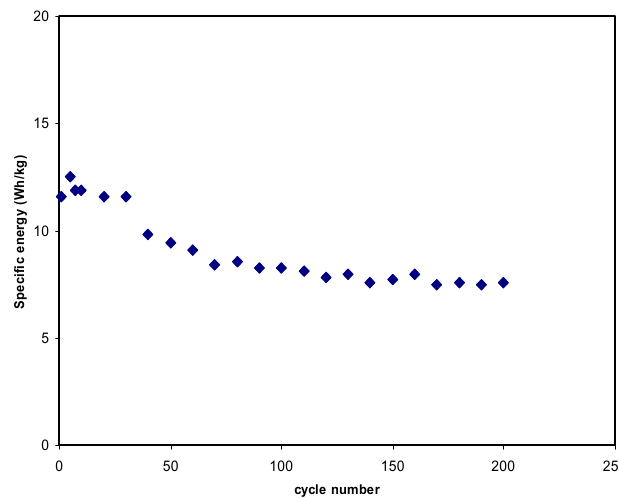
Figure 10. Specific energy of the EDLC at 0.5 mA/cm 2 for 200 complete cycles.